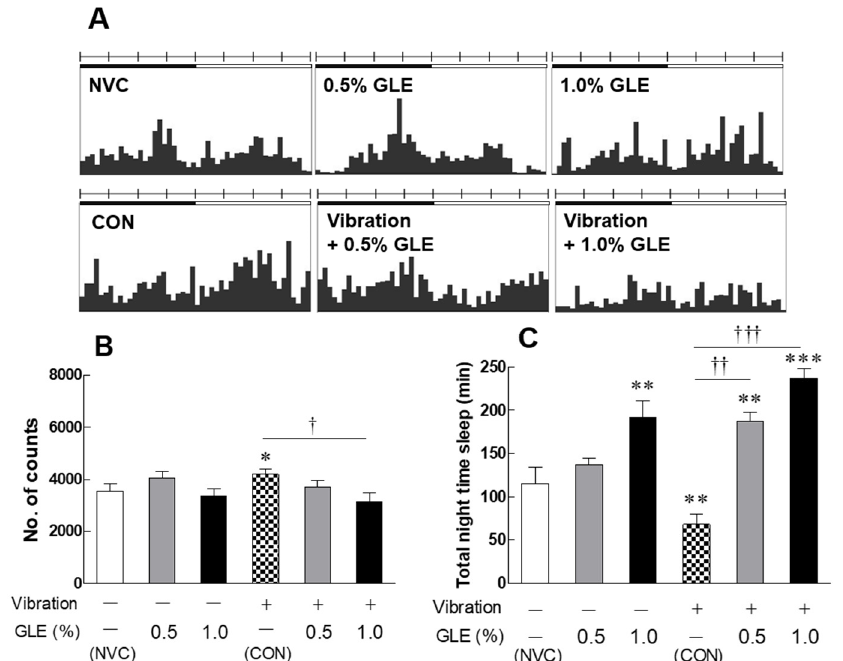
Figure 1. Effects of GLE (green lettuce leaf extract) on behaviors changed by vibration stress in fruit flies. ( A ) Representative actograms for the locomotor activity. The bar above each actogram indicates night (in black) and day (in white) h. ( B ) Nighttime activity and ( C ) duration of nighttime sleep in the locomotor activity monitoring (LAM) system. Experimental groups include the no-vibration-stress control group (NVC), control group (CON, stress-induced vibration), and GLE (green lettuce leaf extract)-treated groups with or without stress (0.5 and 1.0%). Values are presented as the mean ± standard error of the mean (SEM) for each group, n = 150. * p < 0.05, ** p < 0.01, and *** p < 0.001 when compared with the NVC group. † p < 0.05, †† p < 0.01 and ††† p < 0.001 when compared with the stress CON group (ANOVA followed by post-hoc Tukey’s test).